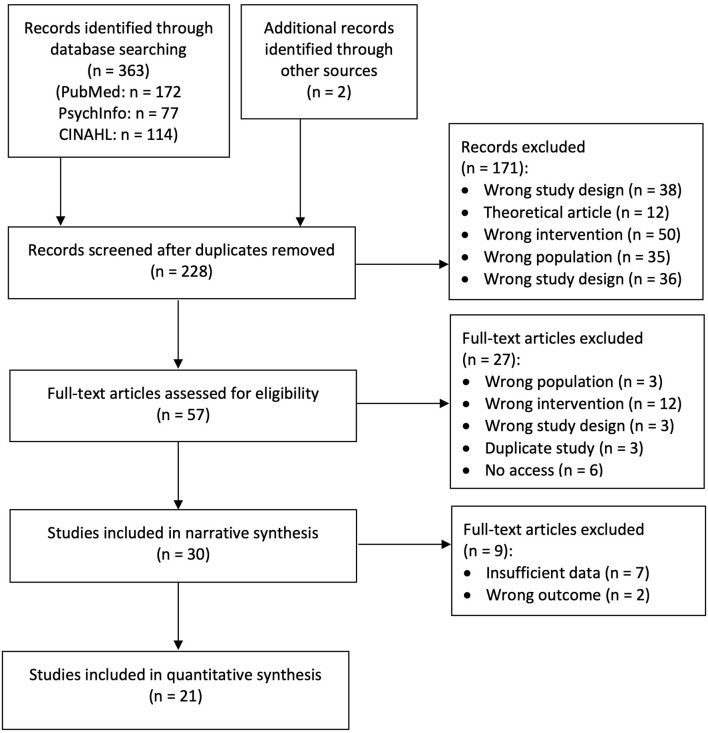
Flow Diagram of study selection. Studies with insufficient data and outcomes which did not fit into meta-analyses categories were not included in quantitative syntheses of results.